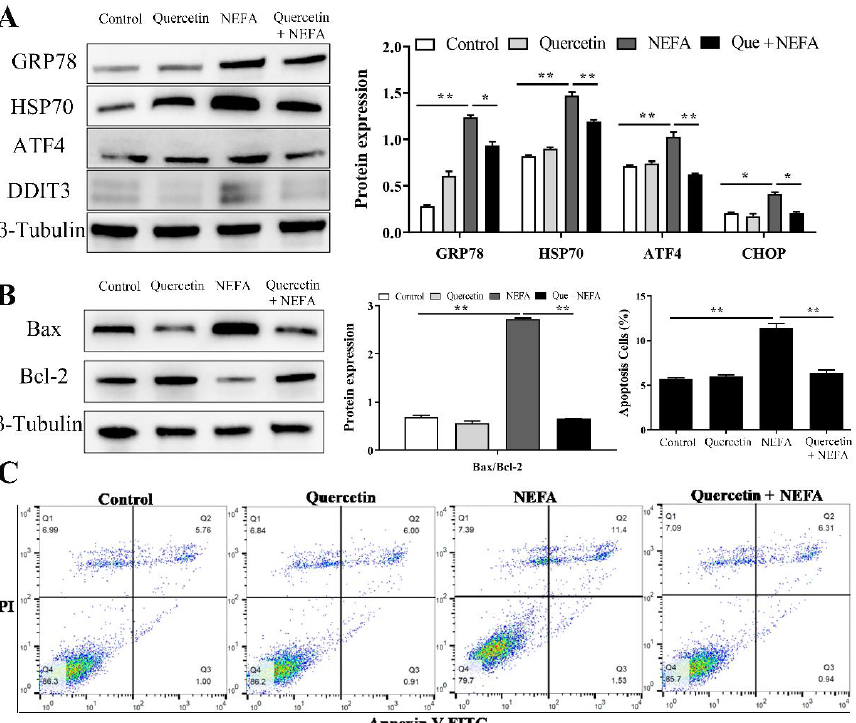
Figure 7. Quercetin alleviated ER stress-mediated apoptosis in NEFA-treated BMECs. Cells were pre-treated with quercetin (10 μ M) for 24 h, then treated with 0.9 mM NEFA for 6 h. ( A ) Protein expression of ER stress marker proteins GRP78, HSP70, ATF4, and CHOP. ( B ) Protein expression of apoptosis marker proteins Bax and Bcl2. ( C ) Cell apoptosis detected by flow cytometry using annexin V FITC/PI double staining. Data are presented as the means ± the standard errors of the mean (SEM) of three independent experiments. * p < 0.05; ** p < 0.01.